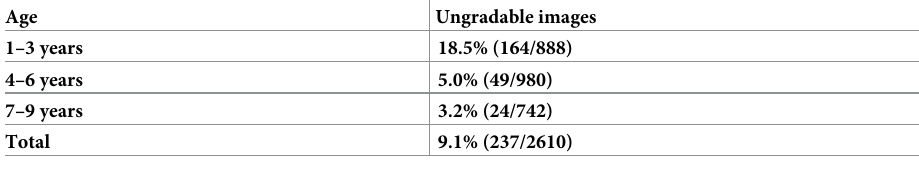
Table 1. Percentage of ungradable images of the 2610 eyes by age